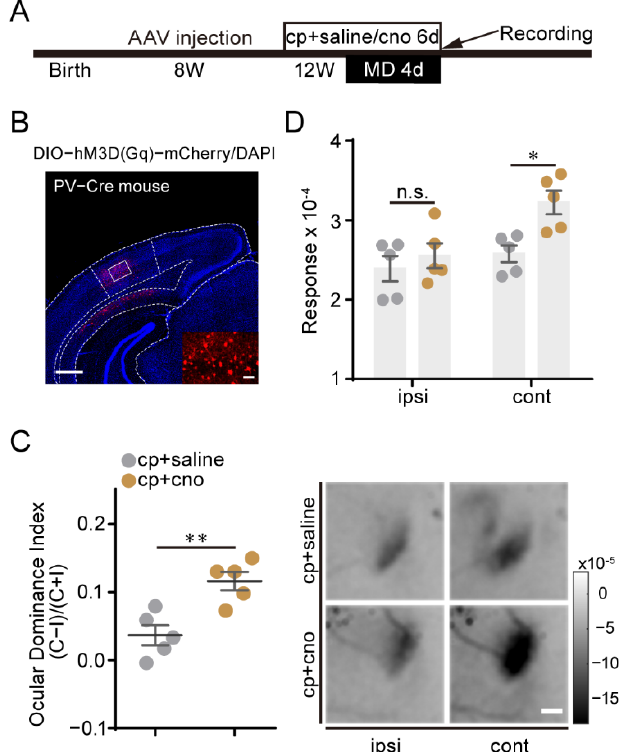
Figure 6. Activation of visual cortex PV neurons attenuates the restoration of OD plasticity induced by Cdk5 inhibition. ( A ) Experimental design. ( B ) A representative image of PV neurons infected with AAV–DIO–hM3Dq. Scale bar, 500 μ m. Enlarged view shown in inset. Scale bar, 50 μ m. ( C ) Left: comparison of ODI measured from PV-Cre mice treated with CP681301 + saline (gray) or CP681301 + CNO (brown) after 4d MD (t = 3.95, p = 0.004, unpaired t -test). Right: Example intrinsic signal images from CP681301 + saline- and CP681301 + CNO-treated PV-Cre mice after MD. Scale bar, 500 μ m. ( D ) After 4d MD, comparison of response magnitude elicited by stimulating the ipsi- lateral eye or contralateral eye for CP681301 + saline- or CP681301 + CNO-treated PV-Cre mice (F(1, 16) = 7.87, p < 0.05, two-way ANOVA with Tukey’s post hoc test). ODI: ocular dominance index; MD: monocular deprivation; ipsi: ipsilateral eye; cont: contralateral eye. Data shown as mean ± SEM.